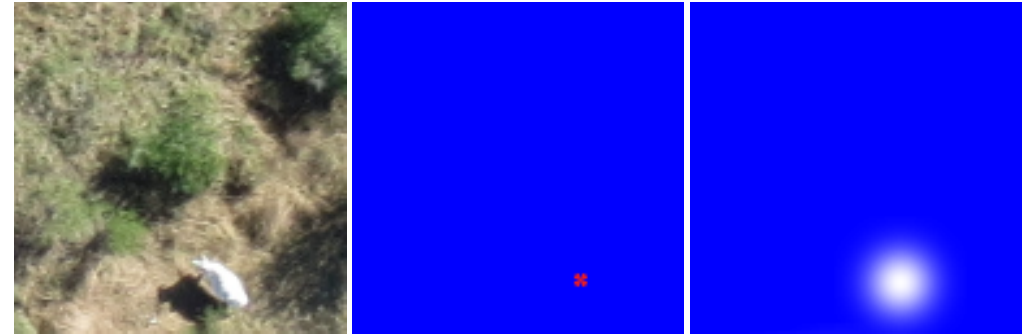
Figure 6. A visualization of density heat-map generation. Starting with the original image, shown left, a point value is hand labeled at the approximate center of the cow. This value, shown middle, is processed using a Gaussian smoothing kernel, the result is shown right. The sum of all pixel values of the right matrix is